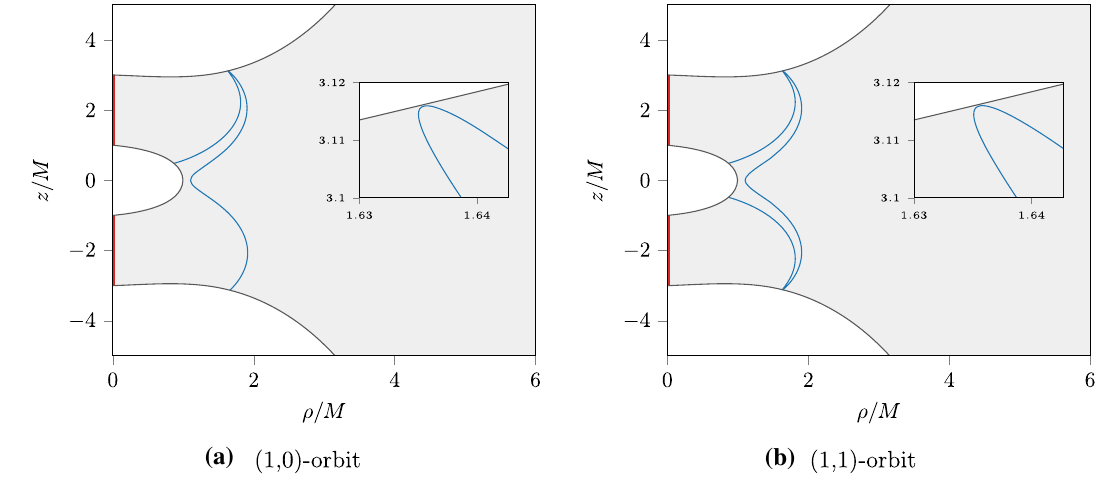
Fig. 15 The higher-order FPOs in Fig. 12, plotted in the (ρ, z ) plane. The insets show that the orbits (blue curves) do not actually touch the level curves (dark grey curves) at the highest point – and by symmetry, the lowest point in b as well Table 3 Summary of the known FPOs in the double Schwarzschild space-time. The notation (ab) refers to the boundary between the regions (a) and (b) in Fig. 14, etc